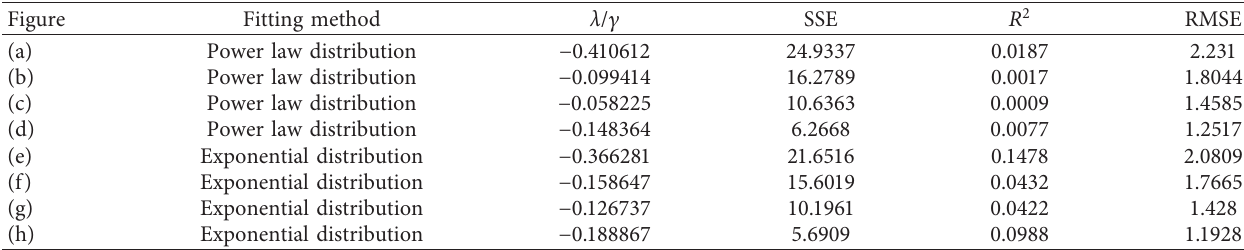
Table 2: Statistics of goodness of fit parameters.